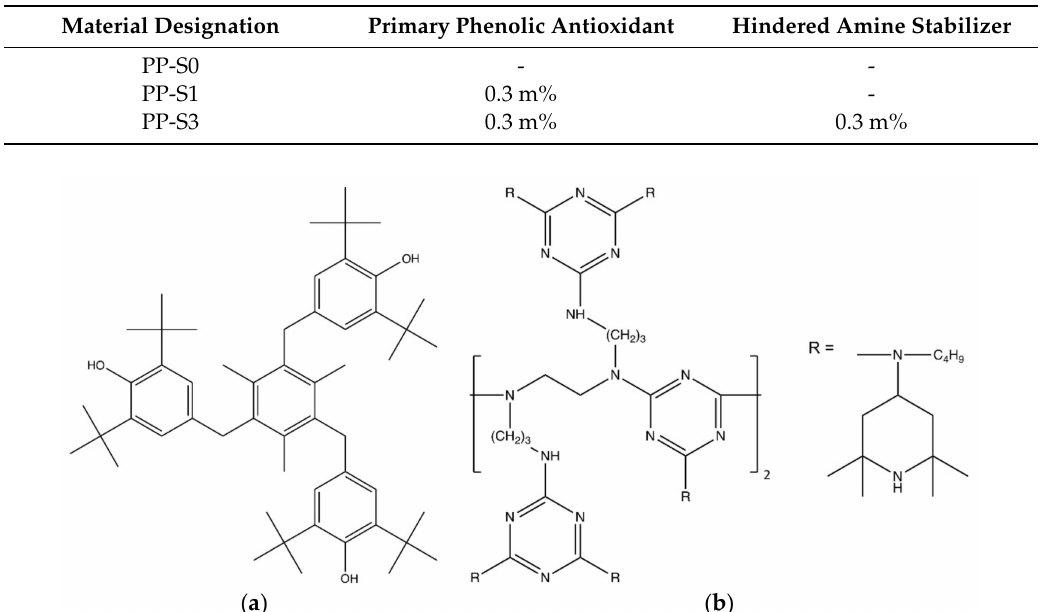
Figure 1. Chemical structure of the stabilizers. ( a ) Primary phenolic antioxidant (Irganox 1330). ( b ) Hindered amine stabilizer (Uvasorb